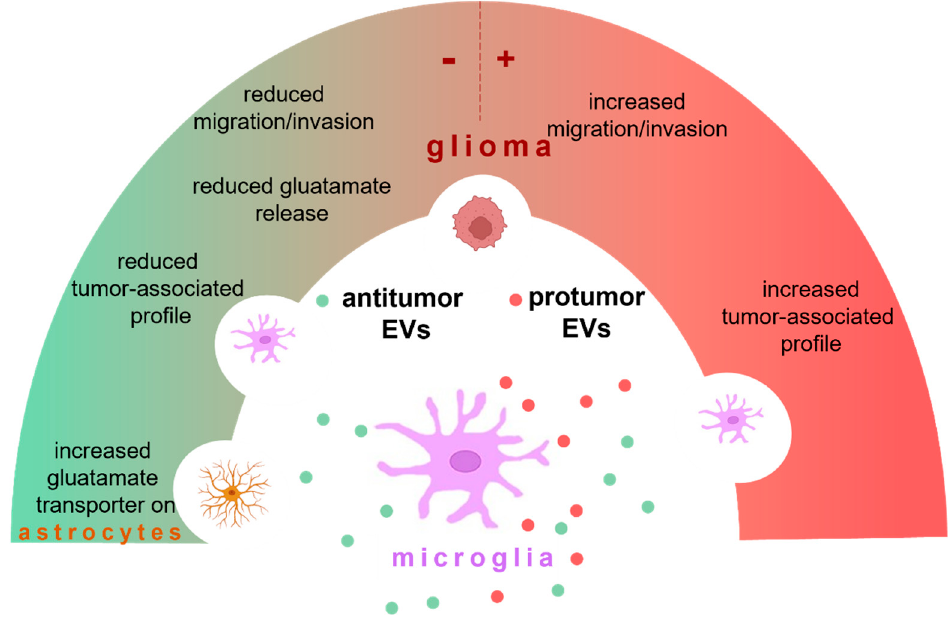
Figure 1. Microglia-derived EVs in glioma.